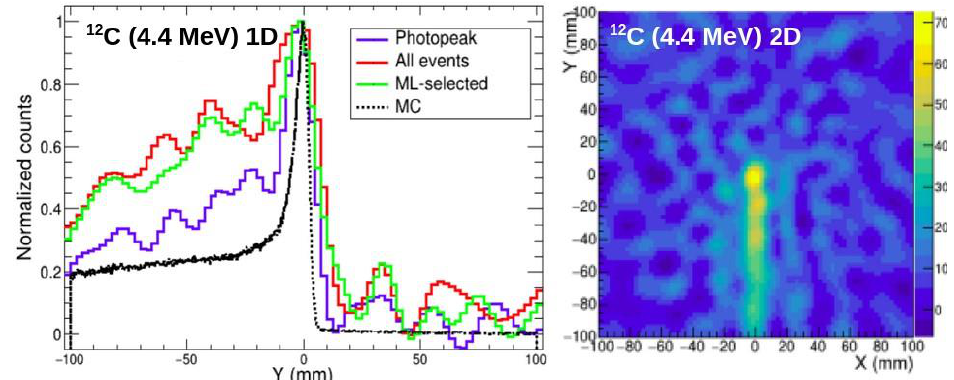
Fig. 5. Reconstructed Compton image for the 4.4 MeV prompt γ-rays (right) and 1D distribution along the proton beam axis comparing the true depth distribution (MC) with the profiles reconstructed from the Compton images (left). See text for